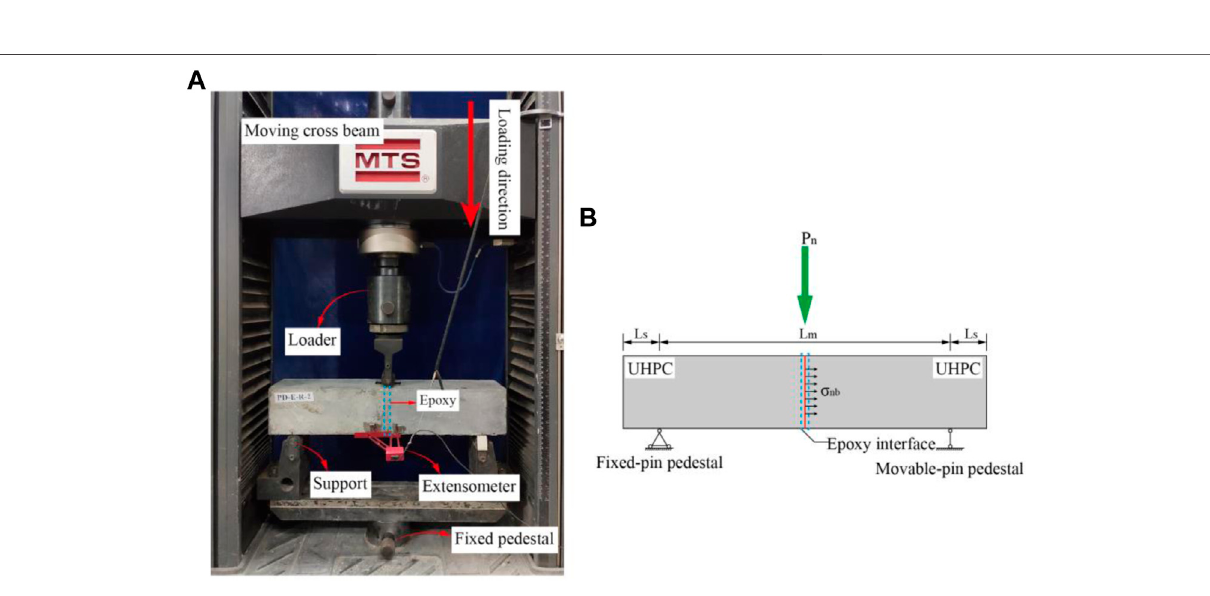
FIGURE 4 | Experimental setup. (A) Loading device diagram. (B) Force